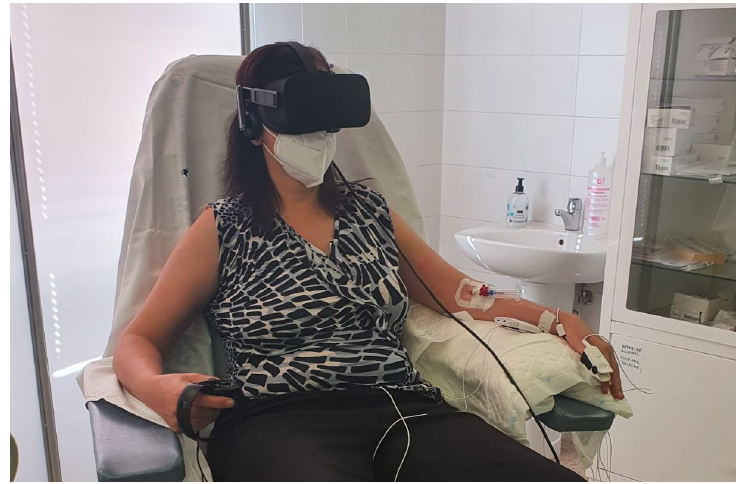
Figure 5. Volunteer ready to start the experiment.